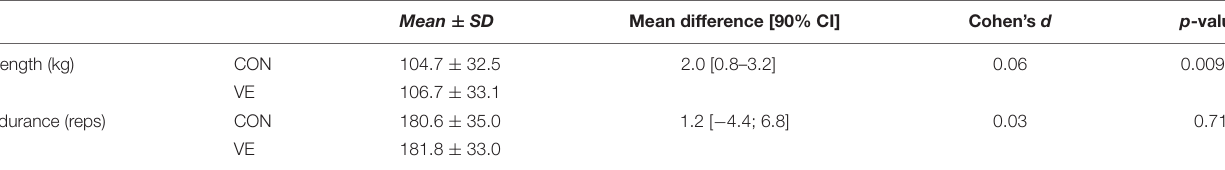
TABLE 3 | Univariate comparison for maximal strength (squat) and endurance (reps) values for the control (CON) and encouragement (VE)